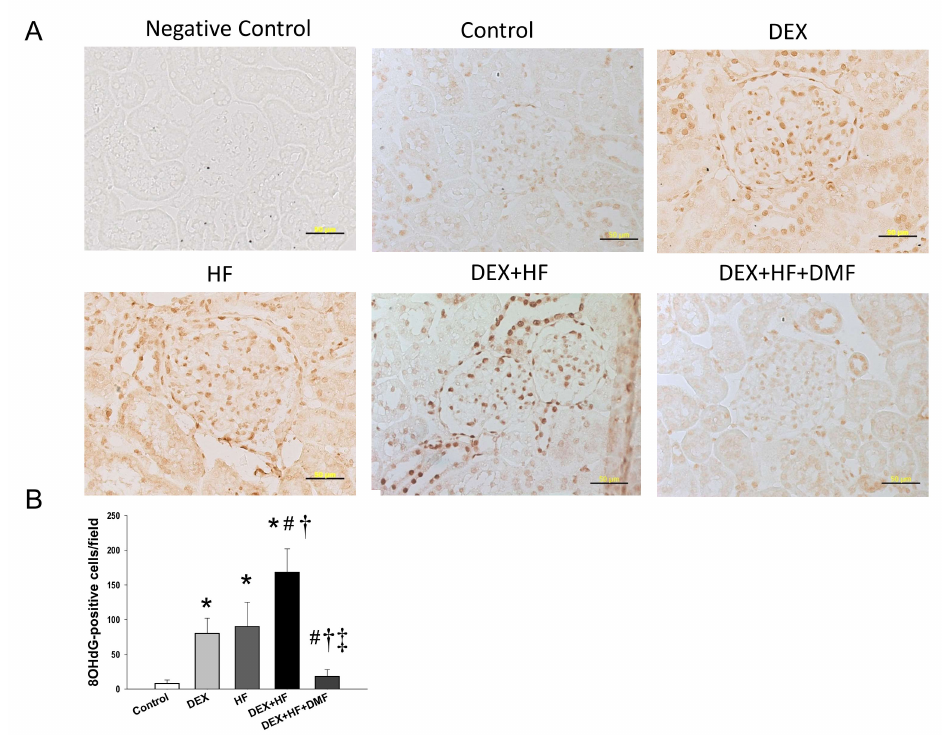
Figure 2. Immunohistochemical staining of 8-hydroxydeoxyguanosine (8-OHdG) at 16-week-old male o ff spring kidney. ( A ) Light micrographs illustrating immunostaining for 8-OHdG in the kidney exposed to prenatal dexamethasone (DEX), postnatal high-fat diet (HF), and dimethyl fumarate (DMF). Bar = 50 µ m. ( B ) Quantitative analysis of 8-OHdG-positive cells per microscopic field ( × 400). * p < 0.05 vs. control; # p < 0.05 vs. DEX; † p < 0.05 vs. HF; ‡ p < 0.05 DEX + HF. n = 8 /